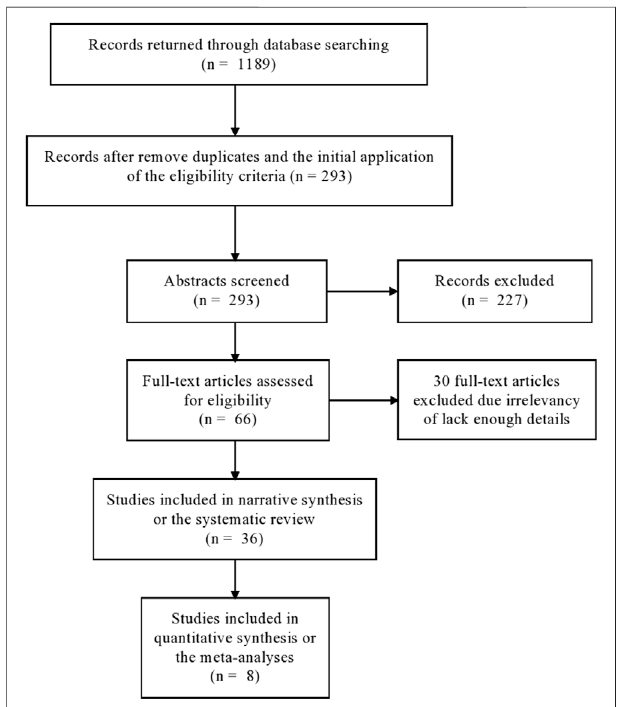
FIGURE 1 | The search strategy of MetS articles in this